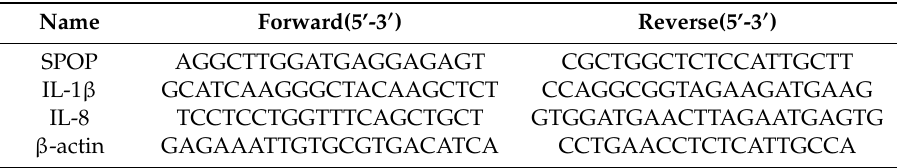
Table 1. Primers used for quantitative real-time polymerase chain reaction (qRT-PCR).